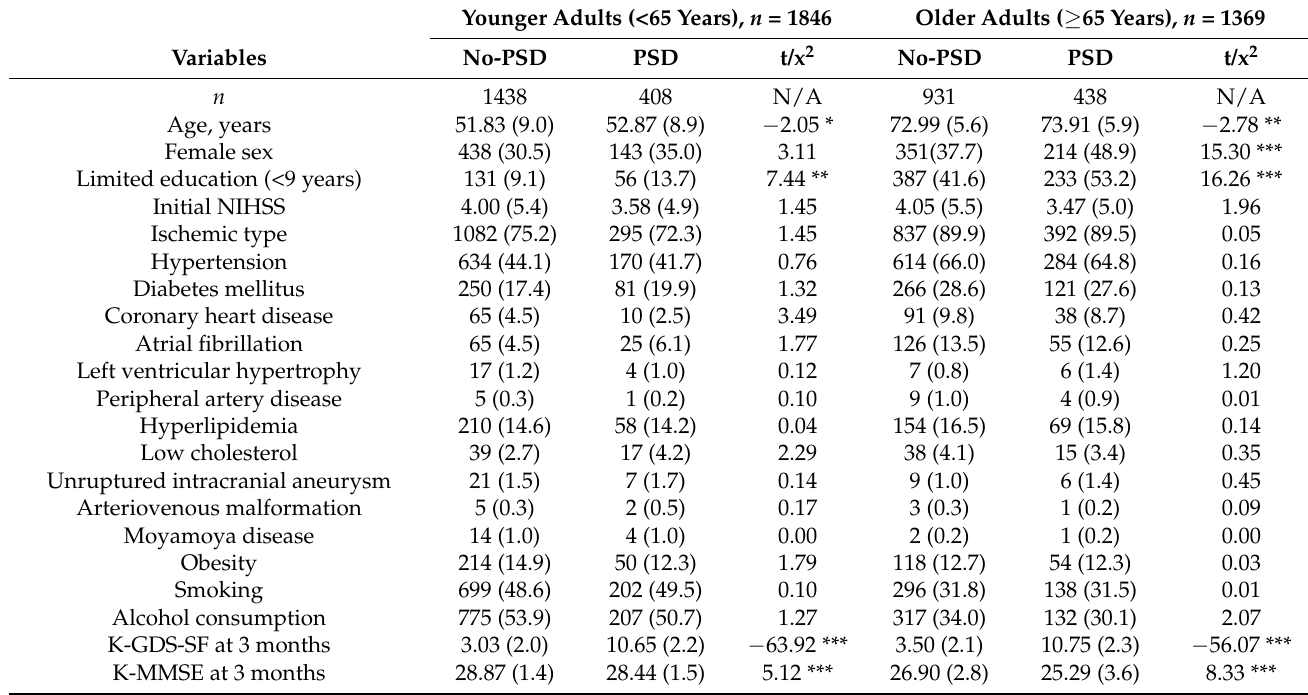
Table 1. Baseline characteristics of the